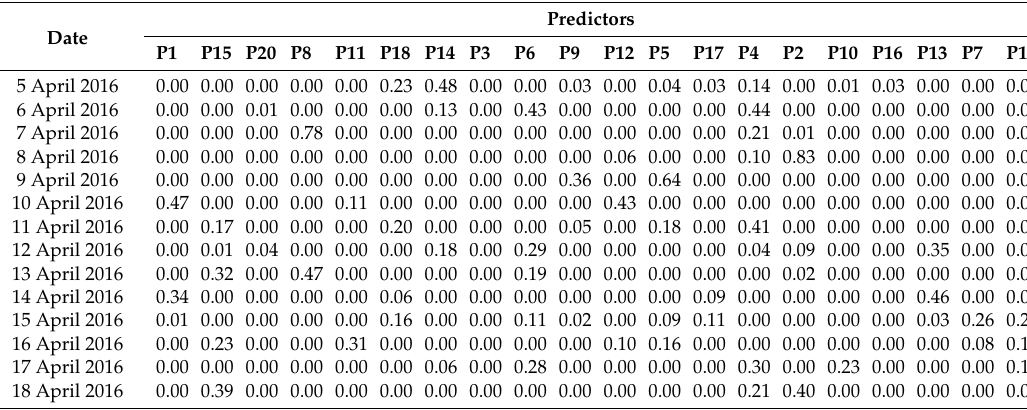
Table 4. Weights u i , D of the PPFMCP model 3 for the predictors P1 to